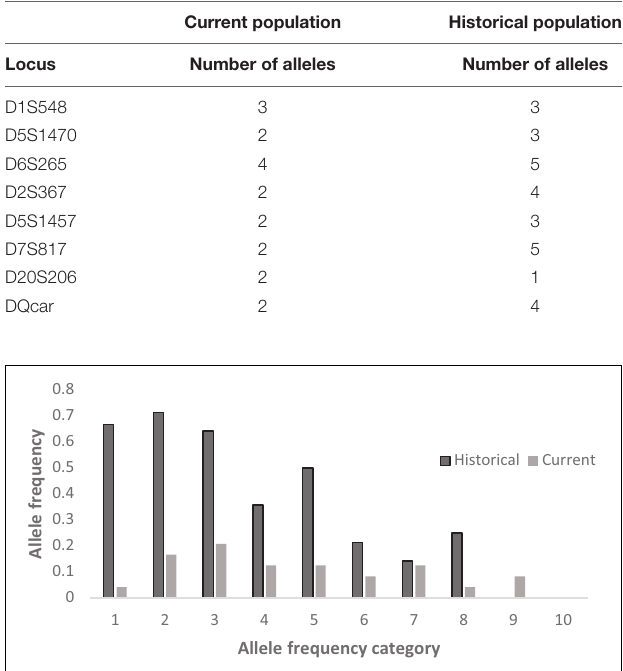
TABLE 7 | The difference in the number of alleles at 8 microsatellite loci between the existing population and the historical population.